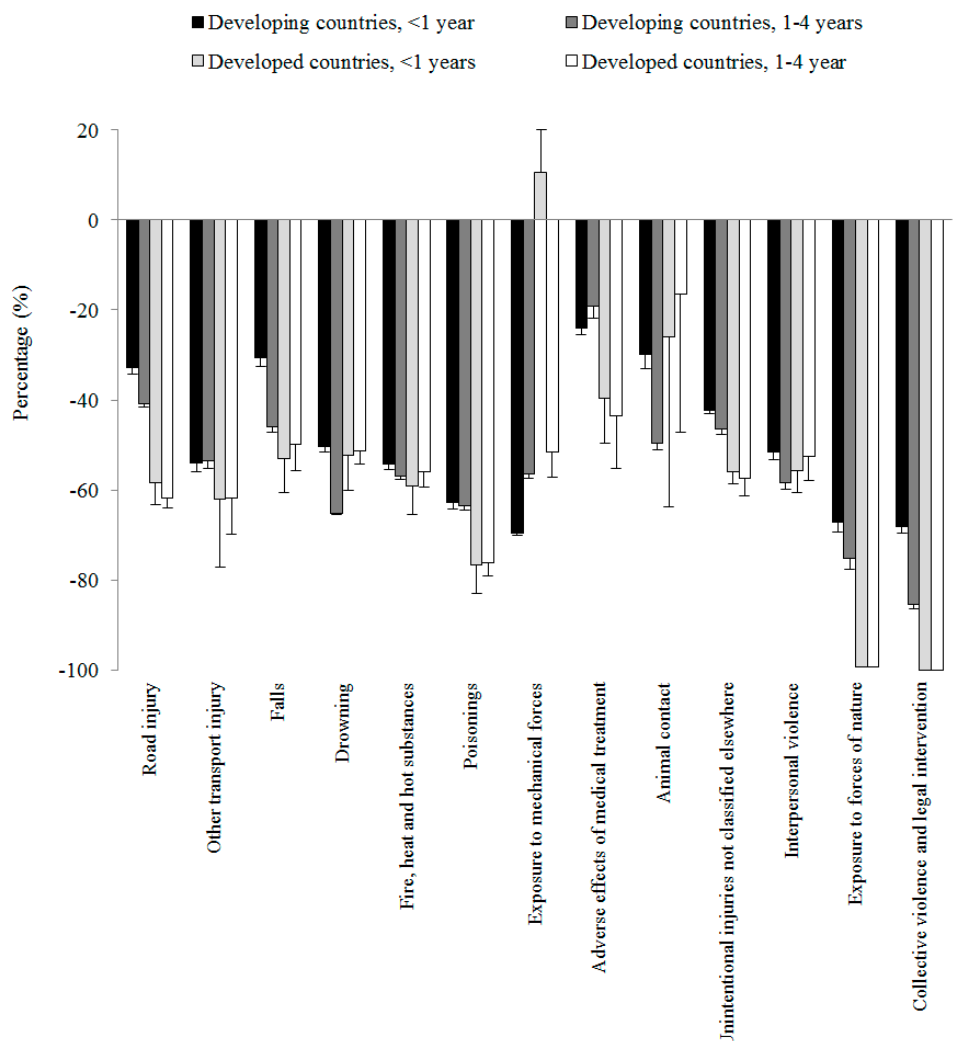
Figure 2. Percent change in under-five injury mortality between 1990 and 2013 by age, cause, and country income.